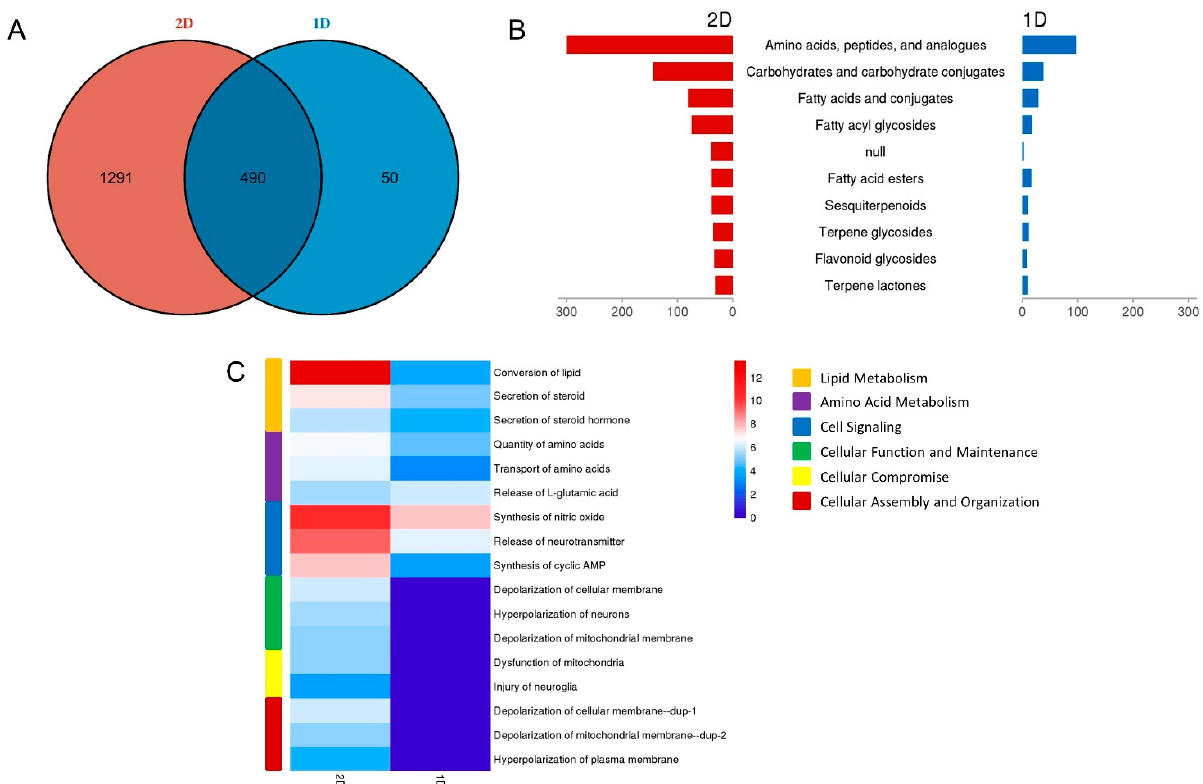
Figure 5. Urine metabolomics comparison between 1D and 2D separation strategy. ( A ) The overlap between the 1D and 2D. ( B ) Chemical class of the urinary metabolites from 1D and 2D. ( C ) Functional comparison of the urinary metabolites from 1D and 2D.